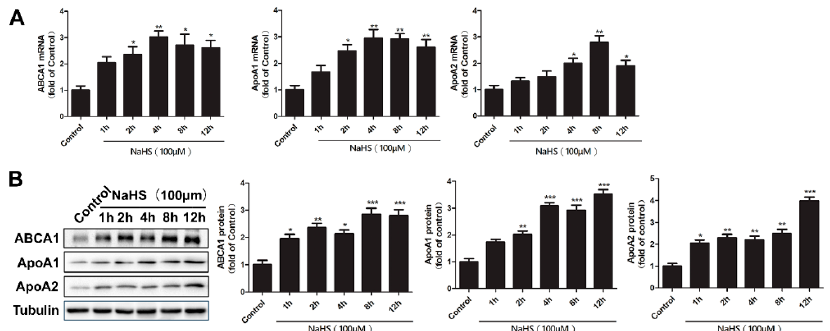
Figure 2. Time course analysis of ABCA1, ApoA1, and ApoA2 expression following NaHS treatment in HepG2 cells. HepG2 cells were treated with 100 μ M NaHS for the indicated time periods. ( A ) RNA was extracted and the relative expression of ABCA1, ApoA1, and ApoA2 mRNA was quantified by RT-qPCR. Bars indicate means ˘ SEM of at least three independent experiments (* p < 0.05, ** p < 0.01 vs. control); ( B ) Total cell lysates were prepared and proteins (20 µ g) from total lysates were subjected to SDS-PAGE, followed by Western blot with indicated antibodies. Tubulin was used as a loading control. The blots were then quantified by ImageJ software ( n = 3, * p < 0.05, ** p < 0.01, *** p < 0.001 vs.